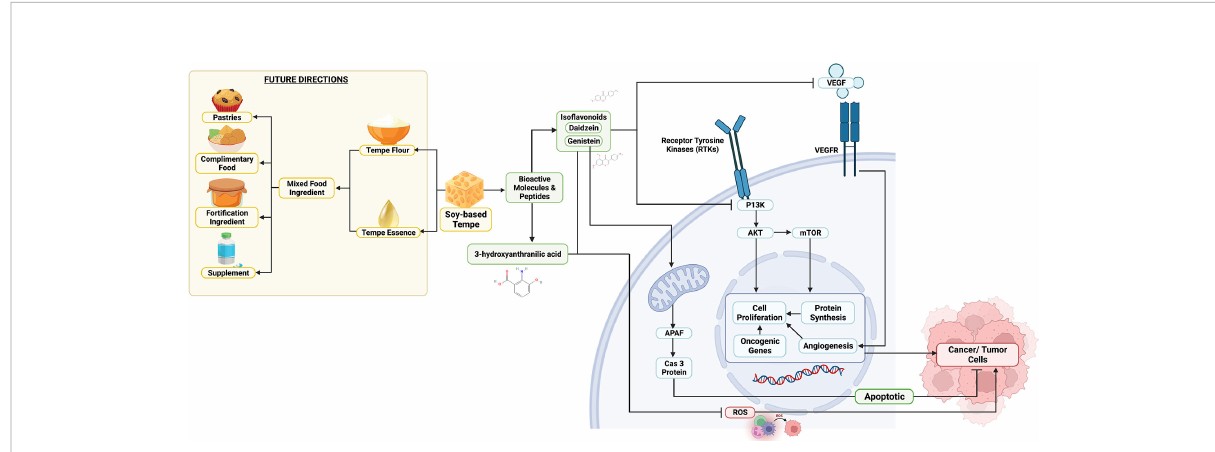
FIGURE 1 Predicted Mechanism of Anticancer Properties from Soy-Based Tempe and Their Future Meal Product